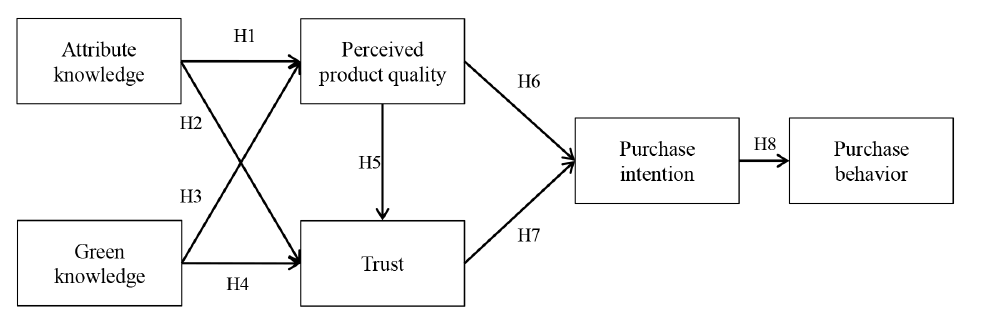
Figure 1. Model of the influence of consumer product knowledge on green tea consumption